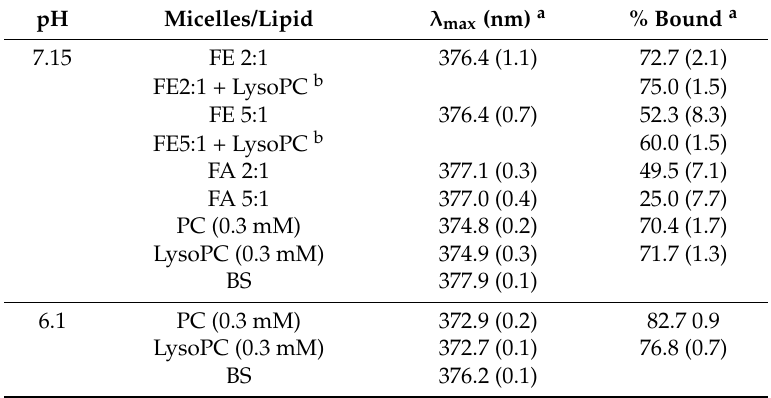
Table 4. Quercetin λ max plateau values and % bound to micelles and